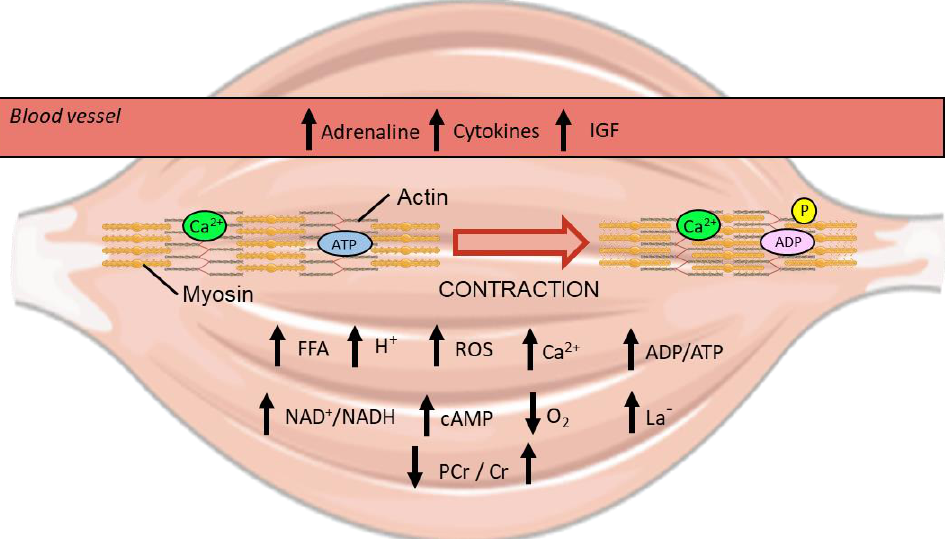
Figure 6. Visualisation of the homeostatic perturbations that occur during exercise within human skeletal muscle [65]. Up and down arrows indicate an increase or decrease in metabolite concentration respectively from exercise. IGF; insulin-like growth factor. ROS; reactive oxygen species. FFA; free fatty acid. PCr; phosphocreatine. Cr; creatine. Ca 2+ ; calcium ion. P; phosphate. ADP; adenosine diphosphate. ATP; adenosine triphosphate. H + ; hydrogen ion. NAD + ; nicotinamide adenine dinucleotide. cAMP; cyclic adenosine monophosphate. La-; lactate.